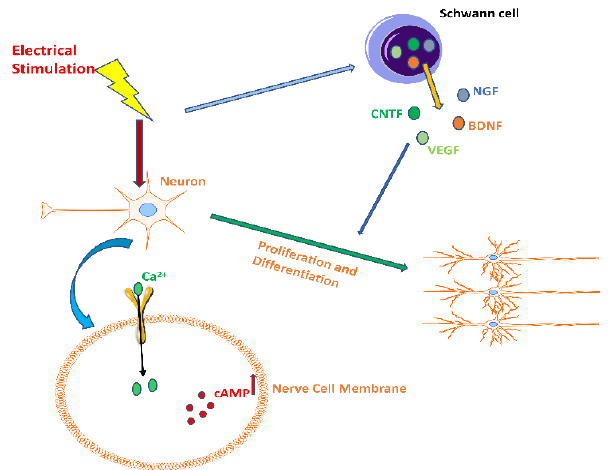
Figure 1. The effect of electrical stimulation on neurons. Electrical stimulation increased the secretion levels of nerve growth factor (NGF), brain-derived neurotrophic factor (BDNF), ciliary neurotrophic factor (CNTF), and vascular endothelial growth factor (VEGF) in Schwann cells, enhancing the activity of Ca 2+ channels in nerve cell membranes, which in turn activated related effector proteins and increased cAMP levels, ultimately promoting neuronal proliferation and differentia- tion.